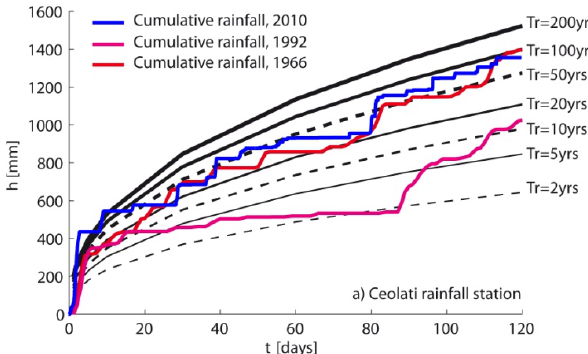
Fig. 4. Rainfall DDF curves for the most intense floods of the last 100yr and rainfall cumulated backward from the last day of the flood events (day=0) up to 120 days before, for the Ceolati rainfall